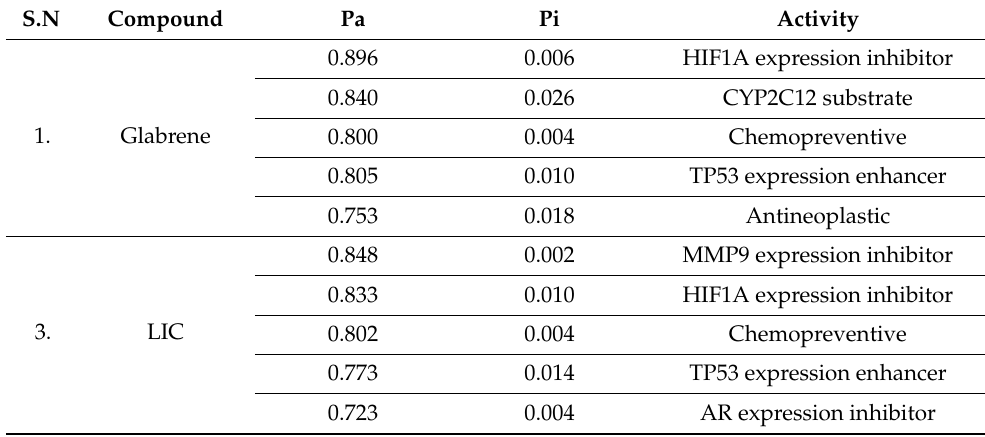
Table 3. Biological properties of the elucidated compounds predicted through the PASS server.